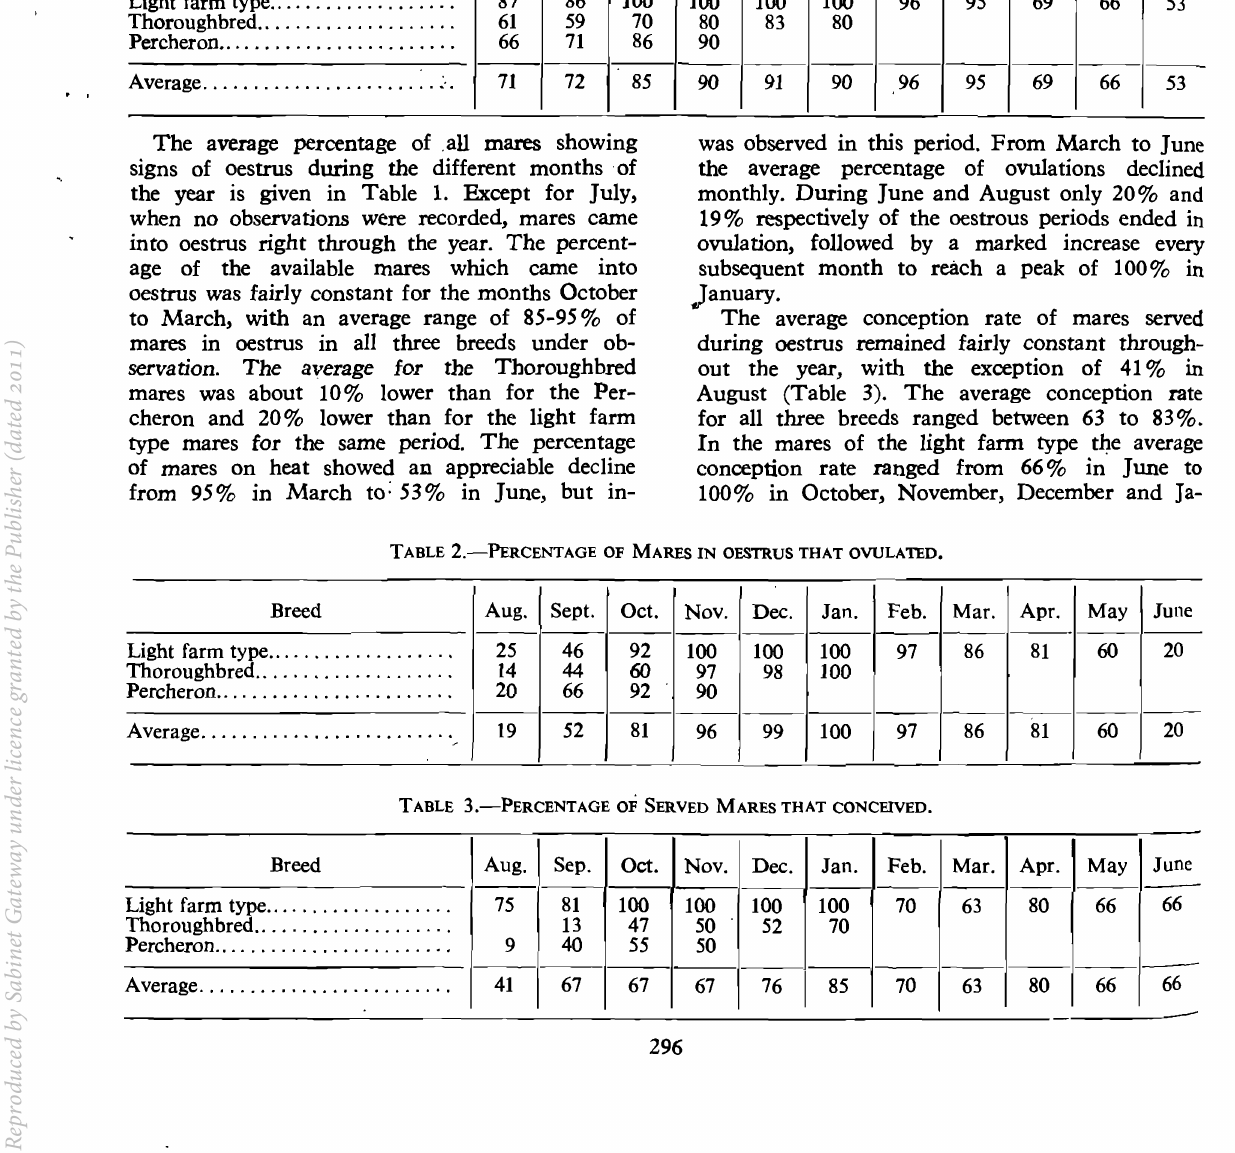
TABLE I.-PERCENTAGE OF MARES SHOWING OESTRUS. Breed.